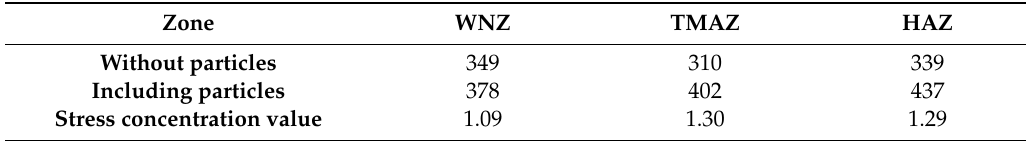
Table 5. Maximum principal strain of RVE in each zone.